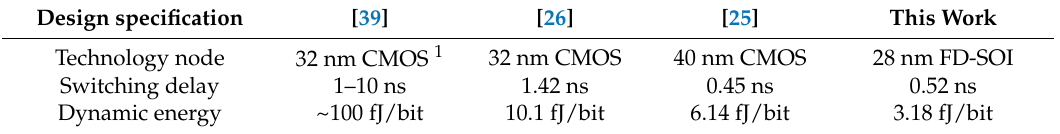
Table 3. Comparison of VCMA switching with different CMOS technology